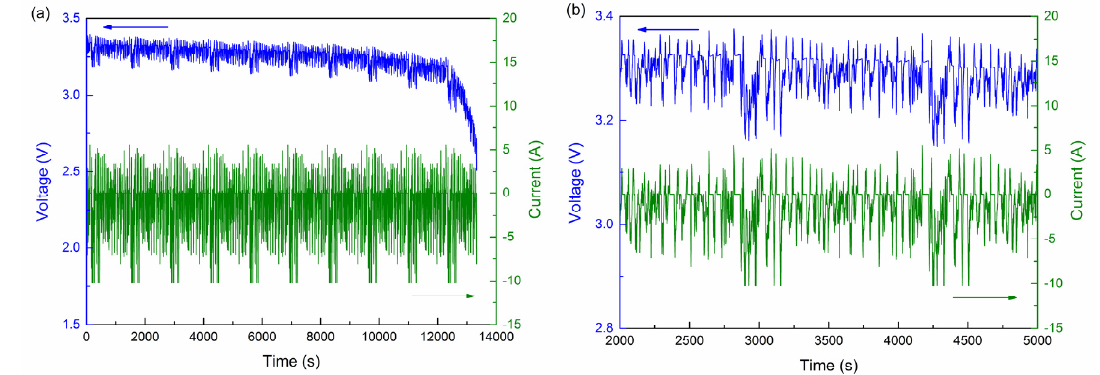
Figure 14. FUDS loading profiles at 40 °C: ( a ) voltage and current vs. time profiles and ( b ) enlarged version for ( a